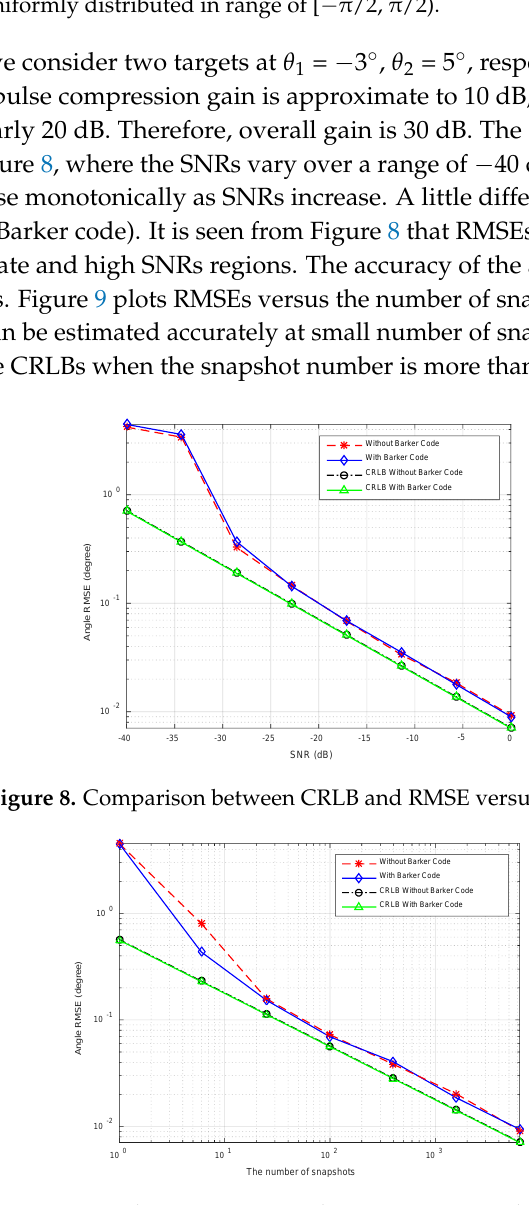
Figure 9. Comparison between CRLB and RMSE versus number of snapshots.